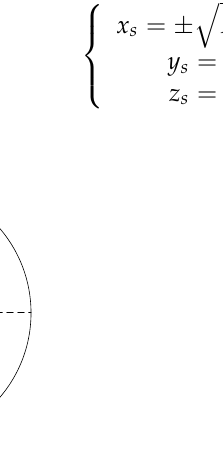
Figure 6. Schematic diagram of standard sphere